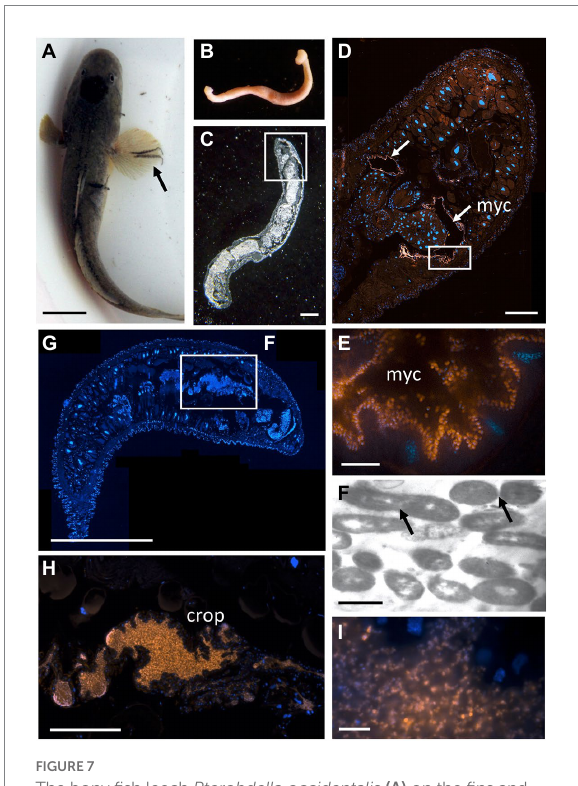
FIGURE 7 The bony fish leech Pterobdella occidentalis (A) on the fins and body of the longjaw mudsucker ( Gillichthys mirabilis ), indicated by the arrow. Scale bar 1 cm. (B) Whole specimen, taken with a Pentax WG-III handheld camera. (C) Specimen embedded in Steedman’s wax and sectioned, imaged via light microscopy. Square indicates region in D . Scale bar, 1 mm. (D) Longitudinal section through the anterior end, showing general bacteria cells in a pair of mycetomes (shown in orange, via Eub338-Cy3), counterstained with DAPI, shown in blue. Square indicates region in E . Scale bar, 200 μ m. (E) Close-up of bacterial cells, shown in orange, attached to the putative mycetome epithelia. Scale bar is 10 μ m. (F) Transmission electron microscopy of a putative mycetome, revealing bacteria-like cells, some which appear to be dividing (arrows). Scale bar, 1 μ m. (G) Longitudinal section through a near complete leech specimen, stained with DAPI. Scale bar, 1 mm. (H) Vibrio -specific cells within the crop (shown in orange, via Cy3), counterstained with DAPI, shown in blue. Scale bar, 200 μ m. (I) . Close-up of bacterial cells, shown in orange, within the crop. Scale bar, 10 μ m. myc,